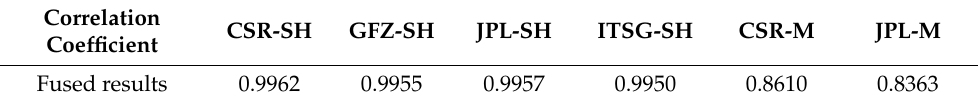
Figure 5. The time series of TWSC results from six GRACE solutions and fused result. Table 4. The correlation coefficients between the fused results and TWSC results from six GRACE solutions (These results have passed the 99% confidence level).